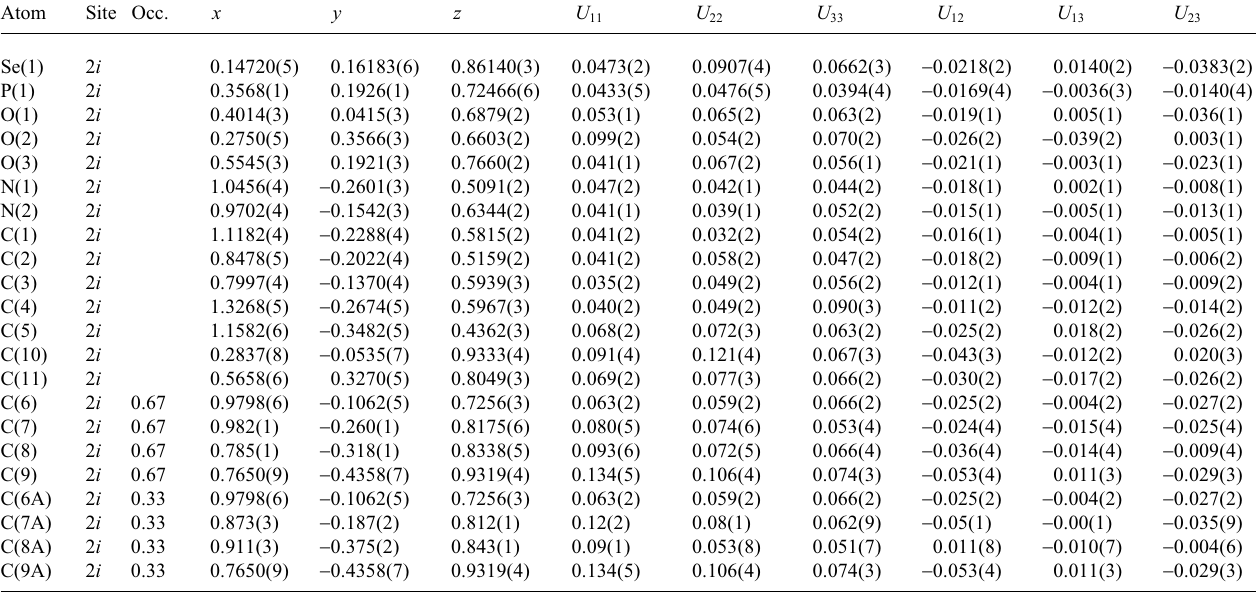
Table 3. Atomic coordinates and displacement parameters (in Å 2 ). Atom Site Occ.